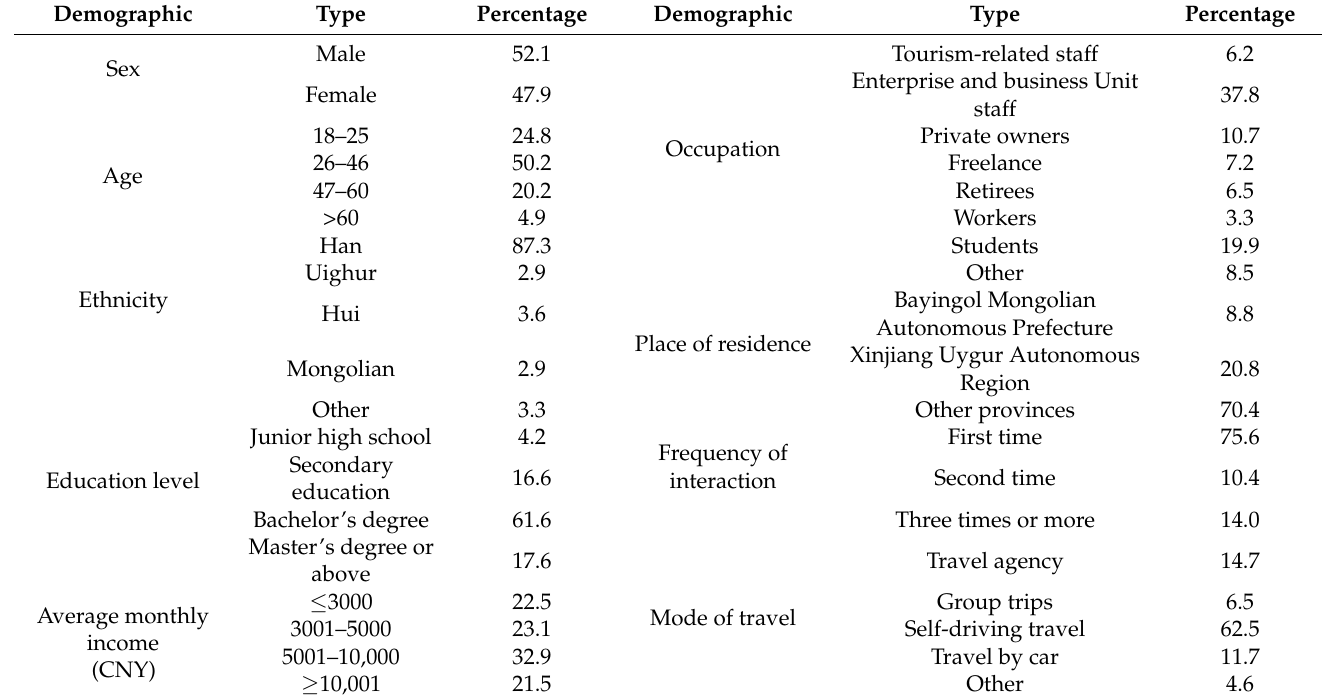
Table 1. Descriptive statistics of the demographic characteristics of the samples ( n = 307).